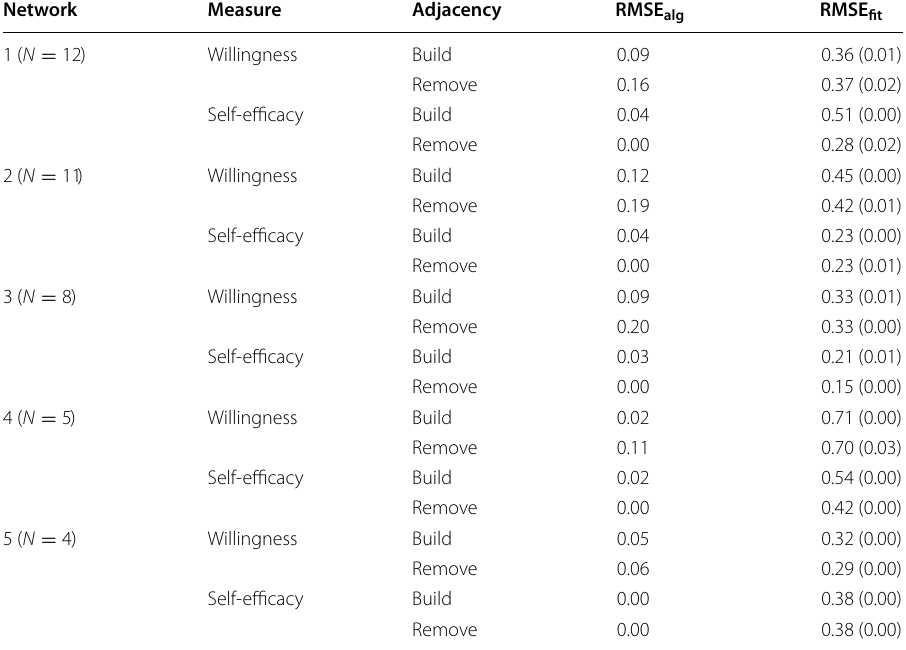
Table 18 Mean self-weight, mean weight, proportion, and number by network, adjacency matrix and leadership for self-efficacy